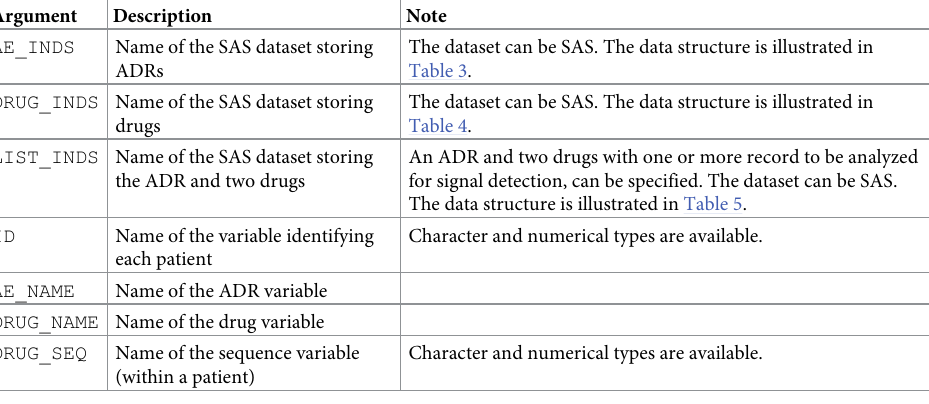
Table 2. Arguments for implementing SignalDetDDI